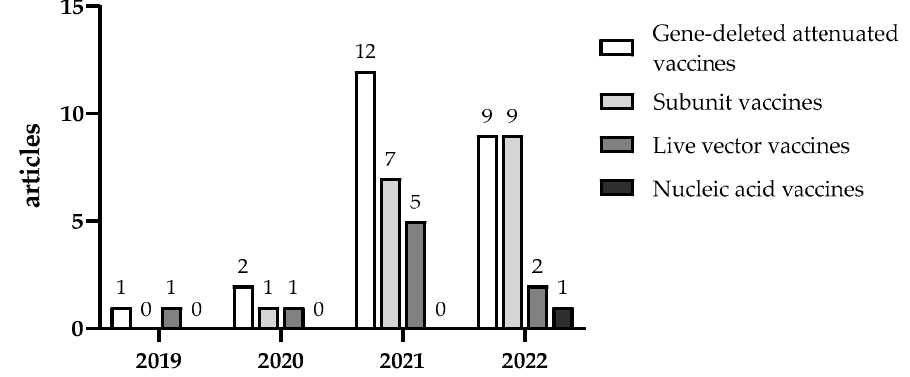
Figure 1. Publication of ASF vaccine articles in China.